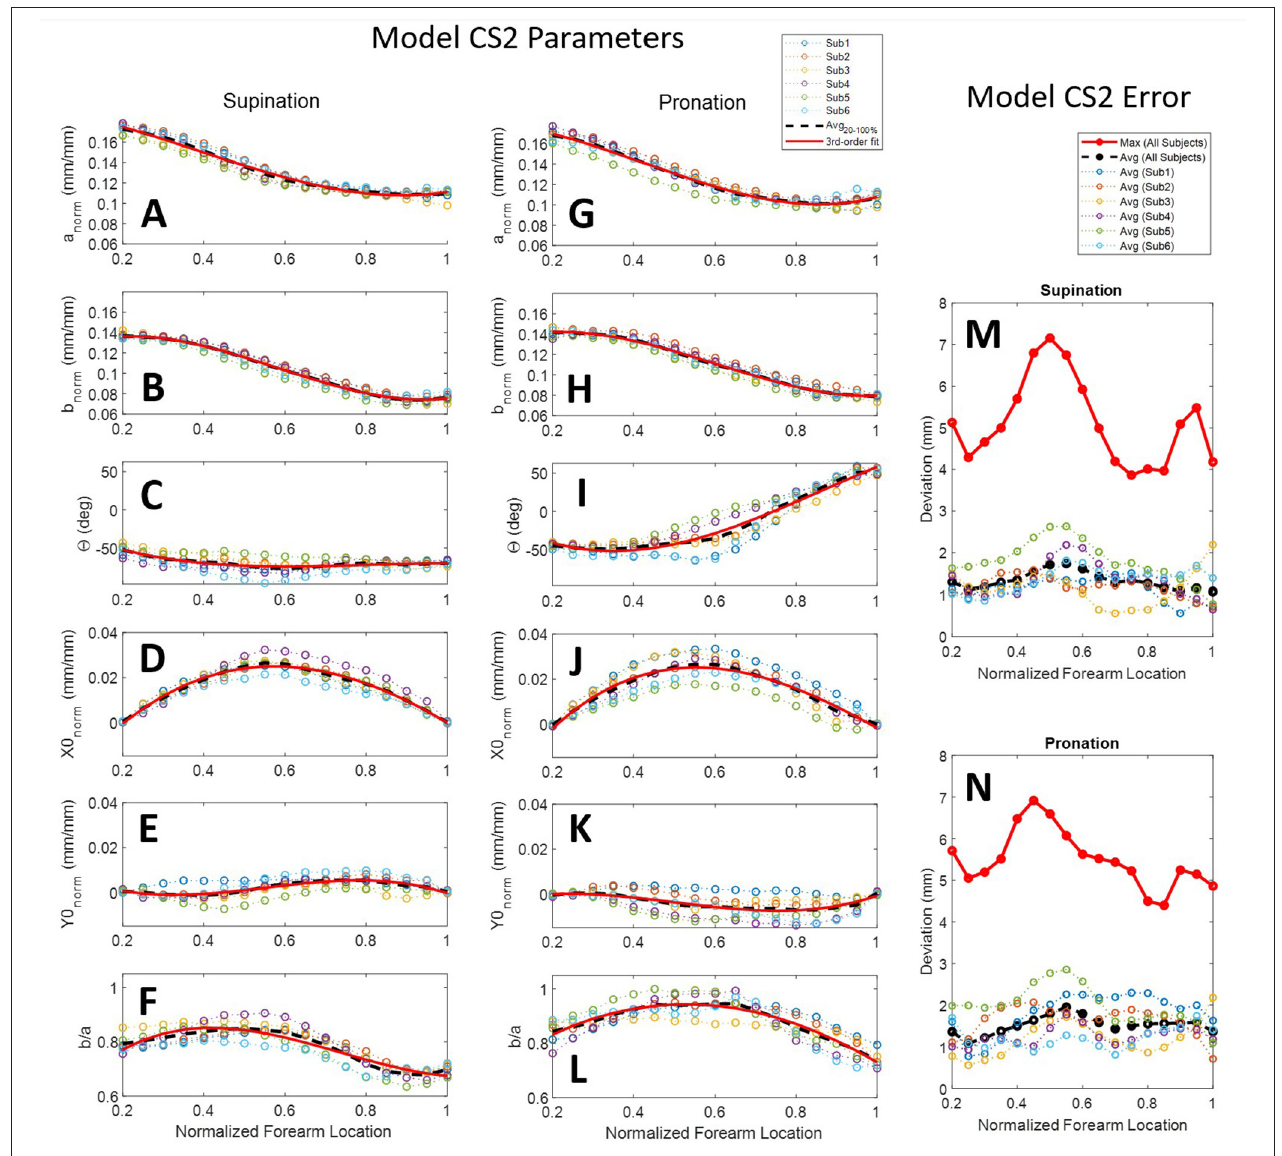
FIGURE 10 | Ellipse-fit model parameters and model error for the aligned combined subjects model CS2: Model parameters for individual subjects, their averages, and their 3rd-order polynomial fit for supination (A–F) and pronation (G–L) scans; Resulting modeling errors of comparing 3D models generated by the 3rd-order polynomials to the original subject scans are shown in in supination (M) and pronation (N) . Legend for panels (A–L) shown above panel (G) . Legend for panels (M,N) shown above panel (M)